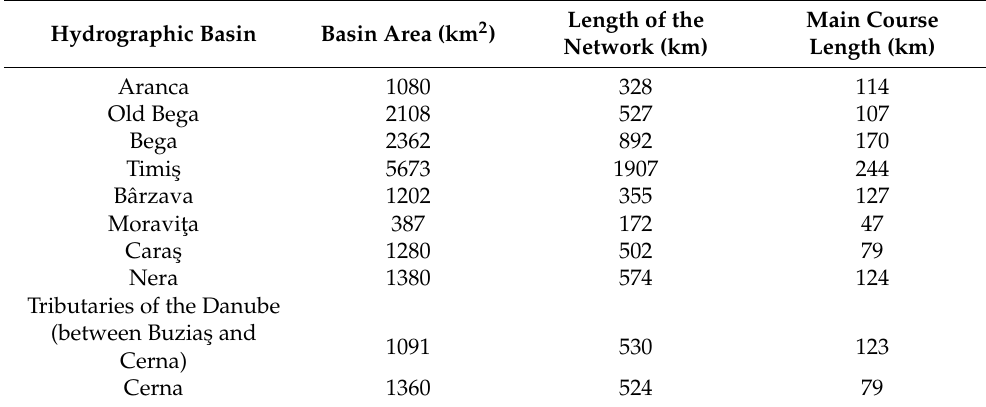
Table 3. Hydrographic network in the Banat hydrographic area (http://www.rowater.ro (accessed on 14 May